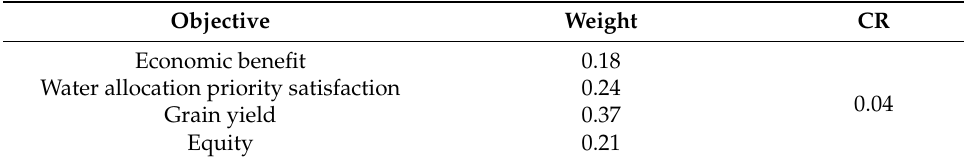
Table 8. Weight of each